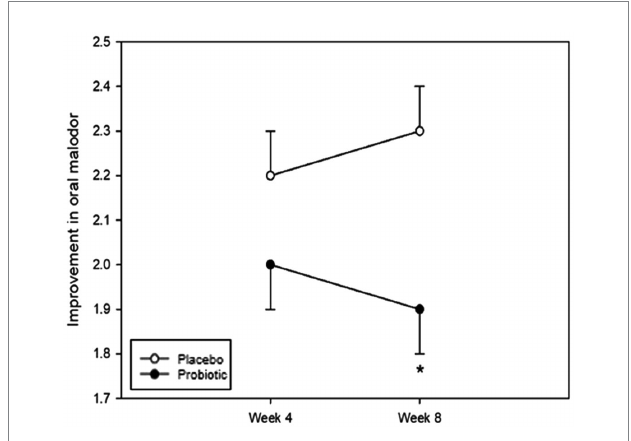
FIGURE 3 Analysis of bad breath improvement (BBI) scores. The BBI score was not significantly different between the groups at week 4; however, there was a significant difference at week 8 ( p = 0.006). Each line represents the LSmean ± SE. *Value of p ≤ 0.05, Student’s t -test.